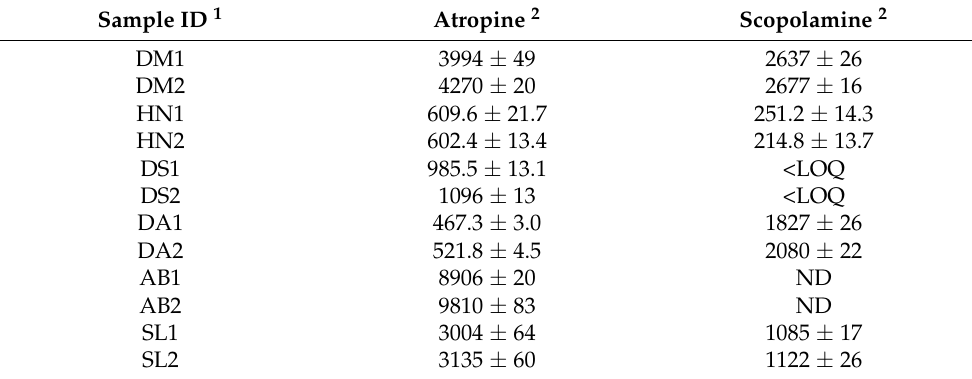
Table 1. Concentration ( µ g/g) of atropine and scopolamine in Solanaceae plants.